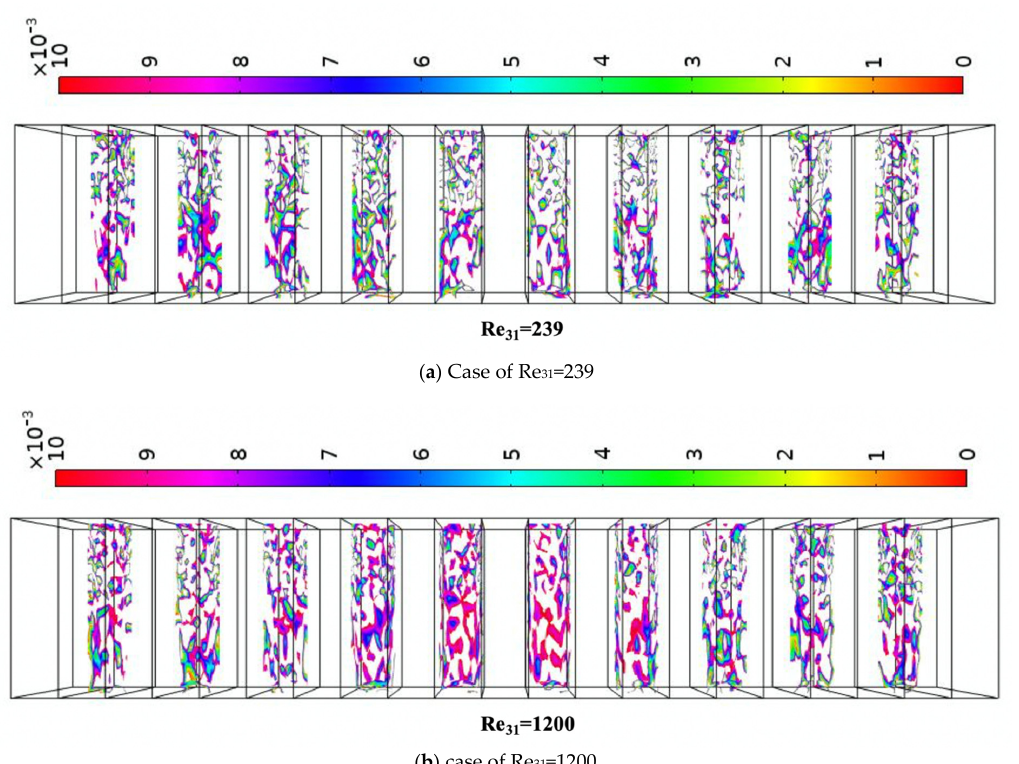
Figure 9. The ratio of the pressure drop and friction factor between nanofluid with different nanoparticles diameter. To investigate the reason behind this matter, the nanoparticles concentrations which are shown in Figures 10 and 11 were examined.